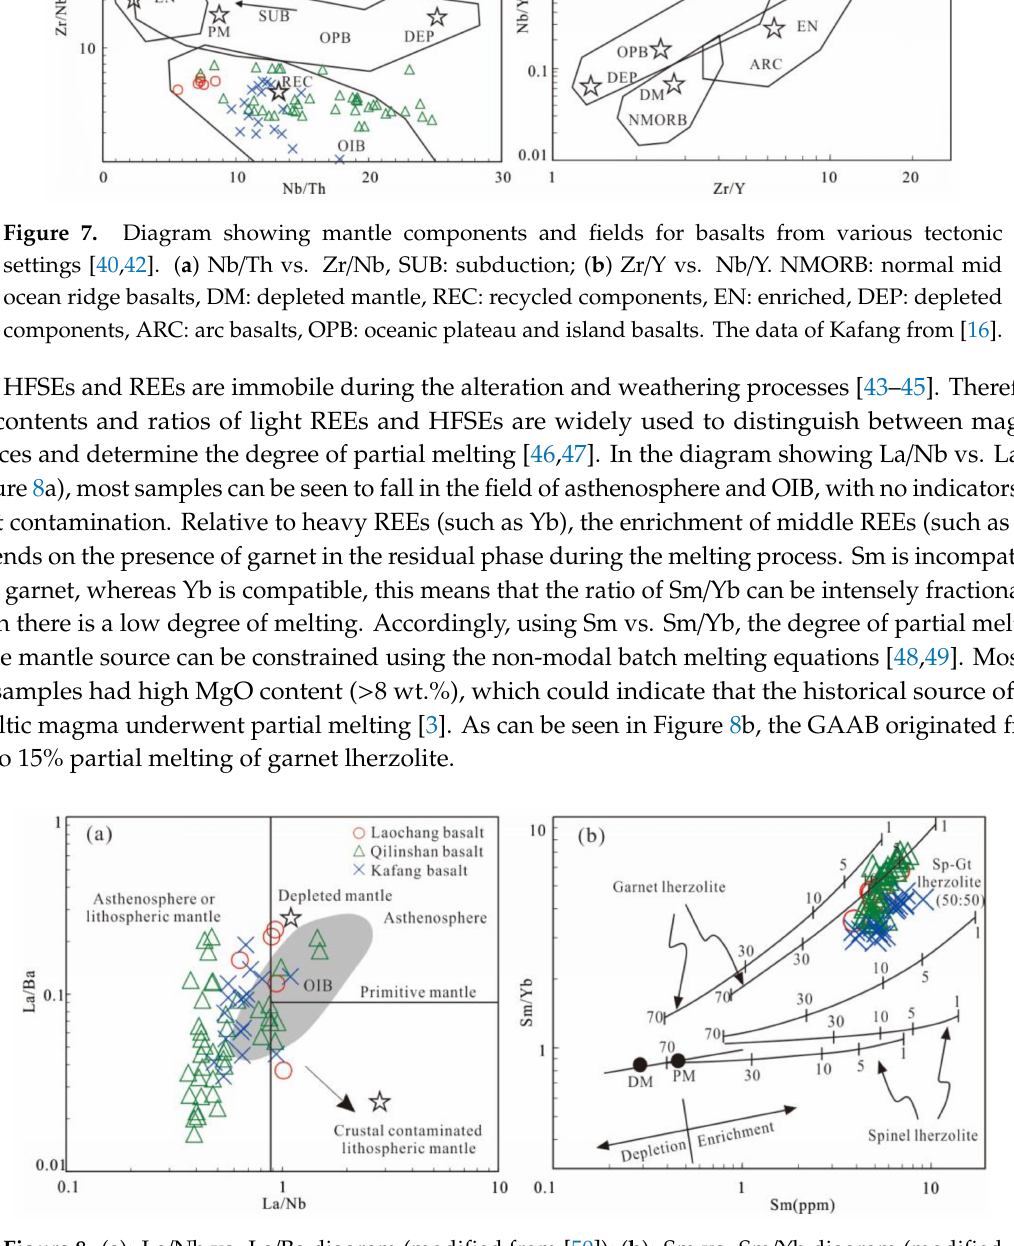
Figure 8. ( a ): La / Nb vs. La / Ba diagram (modified from [50]); ( b ): Sm vs. Sm / Yb diagram (modified from [3]). The data of Kafang from